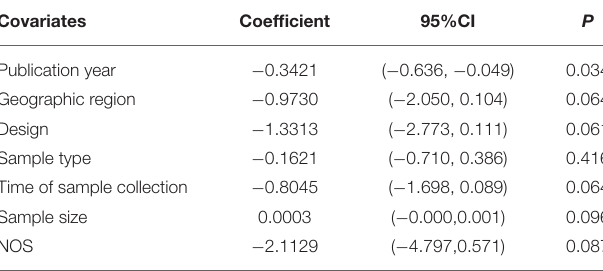
TABLE 2 | The result of meta-regression analysis.